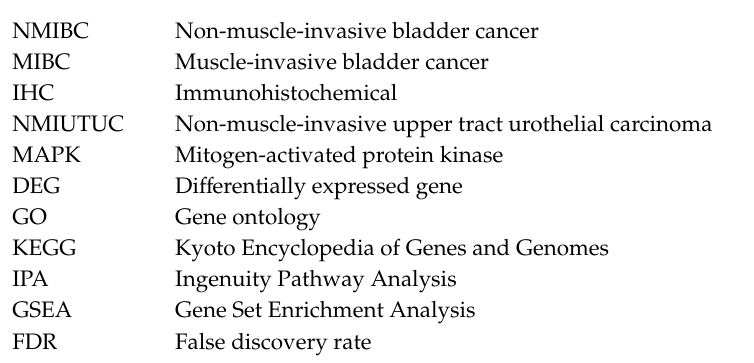
and log-rank tests of relapse-free survival of the groups; Figure S3: Identification of DEGs between the groups; Figure S4: Cell proliferation functions significantly enriched in the groups identified by the GSEA; Figure S5: Metabolism functions significantly enriched in the groups identified by the GSEA; Figure S6: Gene expression characteristics of basal vs. luminal cells of the breast significantly enriched in the groups identified by the GSEA; Figure S7: Identification of DEGs between the Lund cohort groups; Figure S8: KRT gene expression levels of each group; Figure S9: Accuracy of prediction models validated using gene-expression classifier of UROMOL NMIBC subtypes; Table S1: Clinicopathological details of the groups; Table S2: GO and KEGG analyses of the groups; Table S3: Class annotation to the UROMOL intrinsic subtypes by machine learning; Table S4: Clinicopathological details of the Lund cohort groups; Table S5: GO and KEGG analyses of the Lund